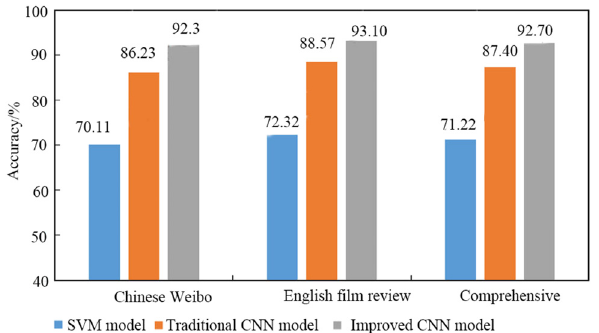
Figure 6: The accuracy of three classi fi cation models for text emotional tendency classi fi cation.